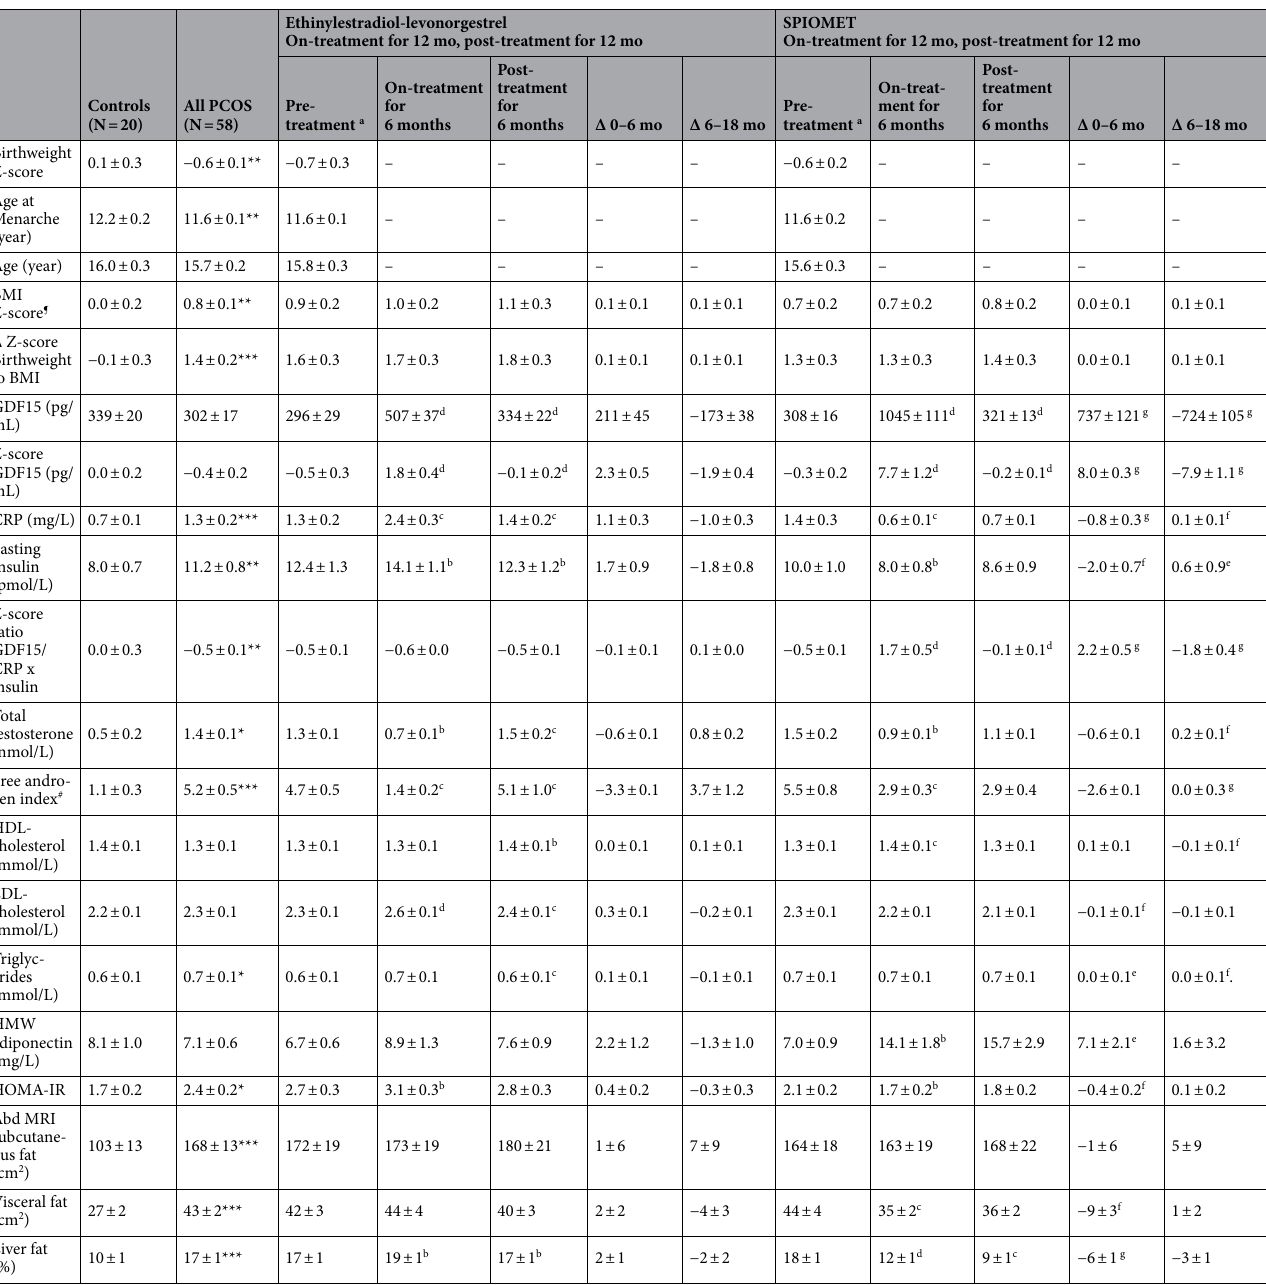
Table 1. Selected data from adolescent girls with polycystic ovary syndrome (PCOS) who were randomized to receive either an oral contraceptive consisting of ethinylestradiol-levonorgestrel (N=29) or a low-dose combination of spironolactone-pioglitazone-metformin (SPIOMET, N=29) for 12 months (12 mo), and who were subsequently followed without treatment for 12 months. Longitudinal results of randomised subgroups are shown: pre-treatment (0 mo), on-treatment for 6 months (6 mo), and post-treatment for 6 months (18 mo). Values are mean ± SEM. BMI body mass index, GDF15 growth differentiation factor 15, CRP C-reactive protein, HDL high-density lipoprotein, LDL-C low-density lipoprotein, HMW adiponectin high-molecular- weight adiponectin, HOMA-IR homeostasis model assessment-insulin resistance, Abd MRI abdominal magnetic resonance imaging. # Testosterone (nmol/L) /SHBG (nmol/L). ¶ Among the 58 girls with PCOS, 23 (40%) were overweight (BMI Z-score between 1.0 and 2.0). a No significant differences between randomised pre-treatment subgroups. b p <0.05, c p≤0.01 and d p ≤0.001 within subgroups for 0–6 months & 6–18 months change (Δ). e p <0.05, f p ≤0.01, g p ≤0.001 between subgroups for 0–6 months & 6–18 change (Δ). * p <0.05, ** p≤0.01, *** p ≤0.001 between controls and